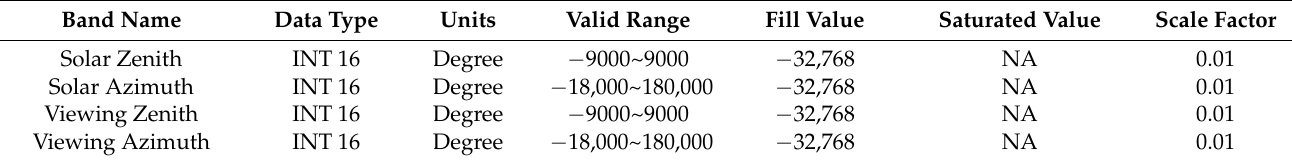
Table 3. ARD angular bands for GF1-WFV. INT16 means 16-bit signed integer.